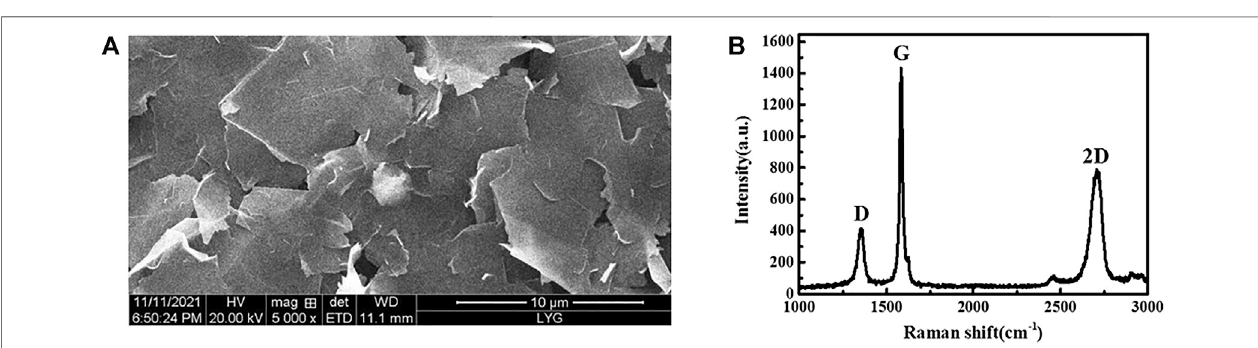
FIGURE 2 | Characterization of the overlapped graphene fi lm: (A) SEM image of the overlapped graphene fi lm without strain; (B) Raman spectrum of the graphene fi lm.